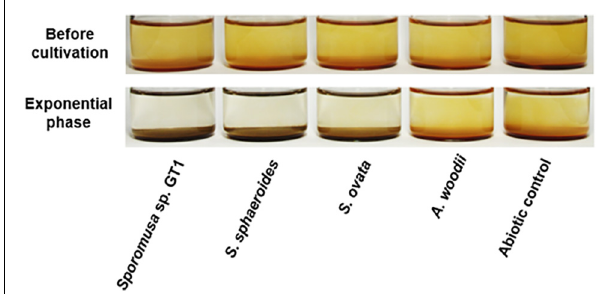
FIGURE 1 | Appearance of homoacetogen cultures in the presence of HFO. Homoacetogens were cultivated on ethanol (20 mM) in the presence of HFO.